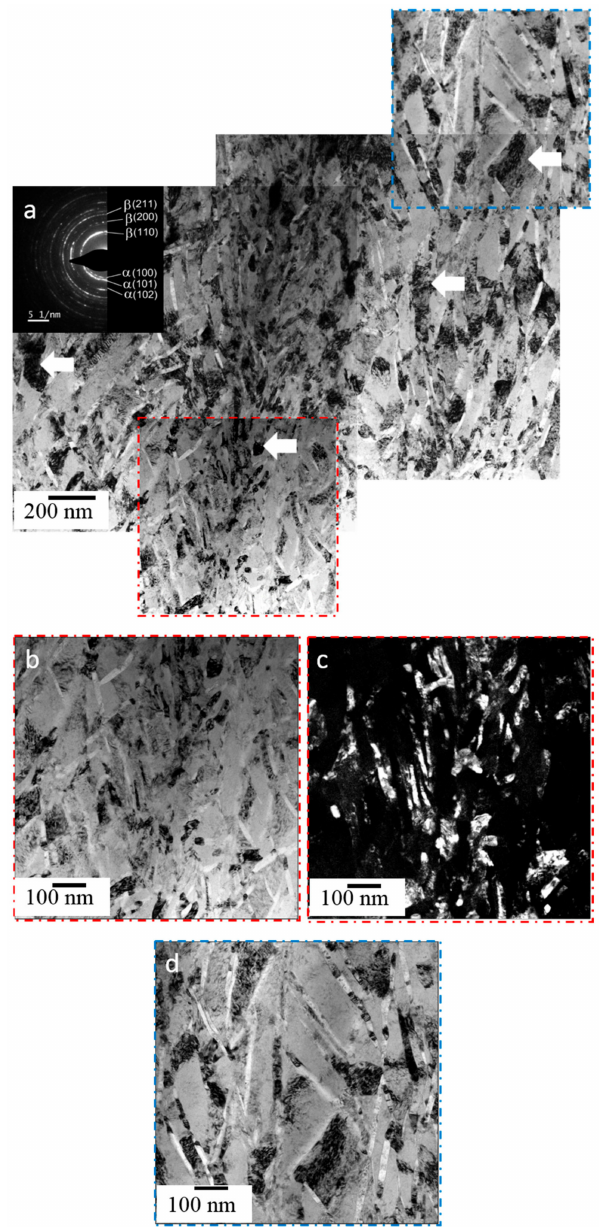
Figure 3. Transmission electron microscopy (TEM) from the expanded shear band region: ( a ) Montage of bright field (BF) images with selected area diffraction pattern (SADP) inset indexed to the β and α phases. ( b ) BF image and ( c ) corresponding hollow cone dark field (HCDF) image from the red dashed region in ( a ) formed from β (110) and α (100), (002), (101) diffraction rings. ( d ) Higher magnification BF image from the blue dashed region in ( a